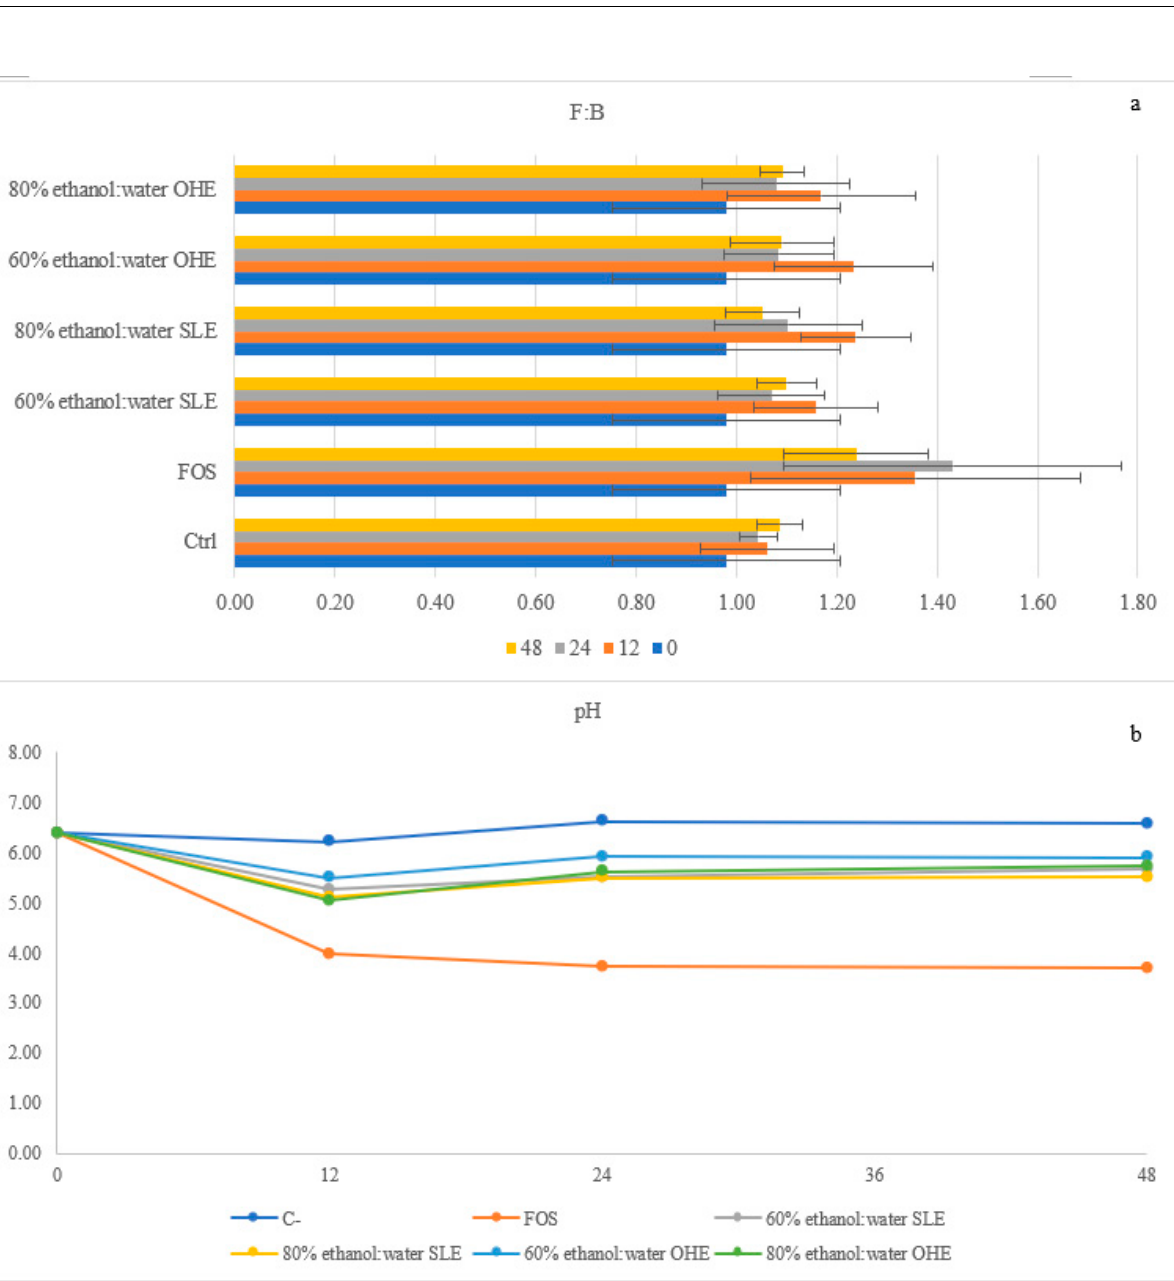
Figure 5. Firmicutes: Bacteroidetes (F:B) ( a ) ratio and variation of the pH ( b ) throughout fermentation of FOS and BSG flours with human microbiota.